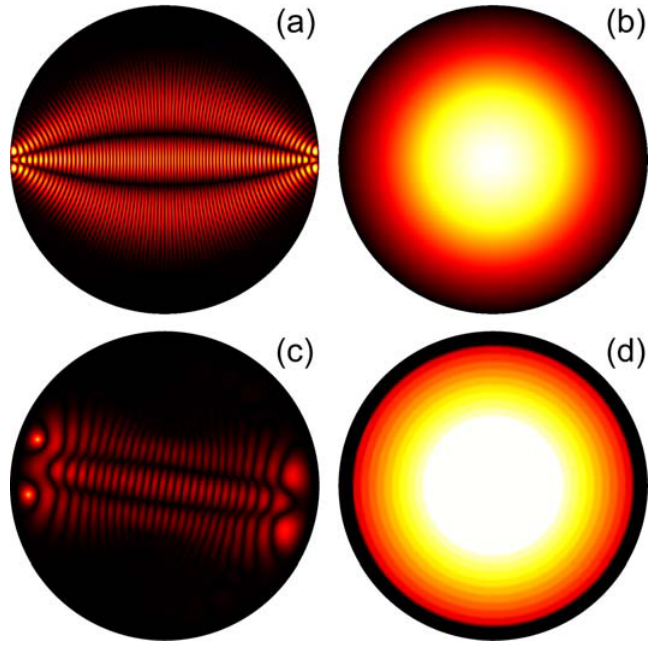
Figure 9. Numerical simulations of imaging properties of the fisheye ( a ) and inverted Eaton ( c ) lenses. Points near the edge of the fisheye and Eaton lenses are imaged into opposite points. Refractive index distributions in these lenses are shown to their right in panels ( b ) and ( d ).